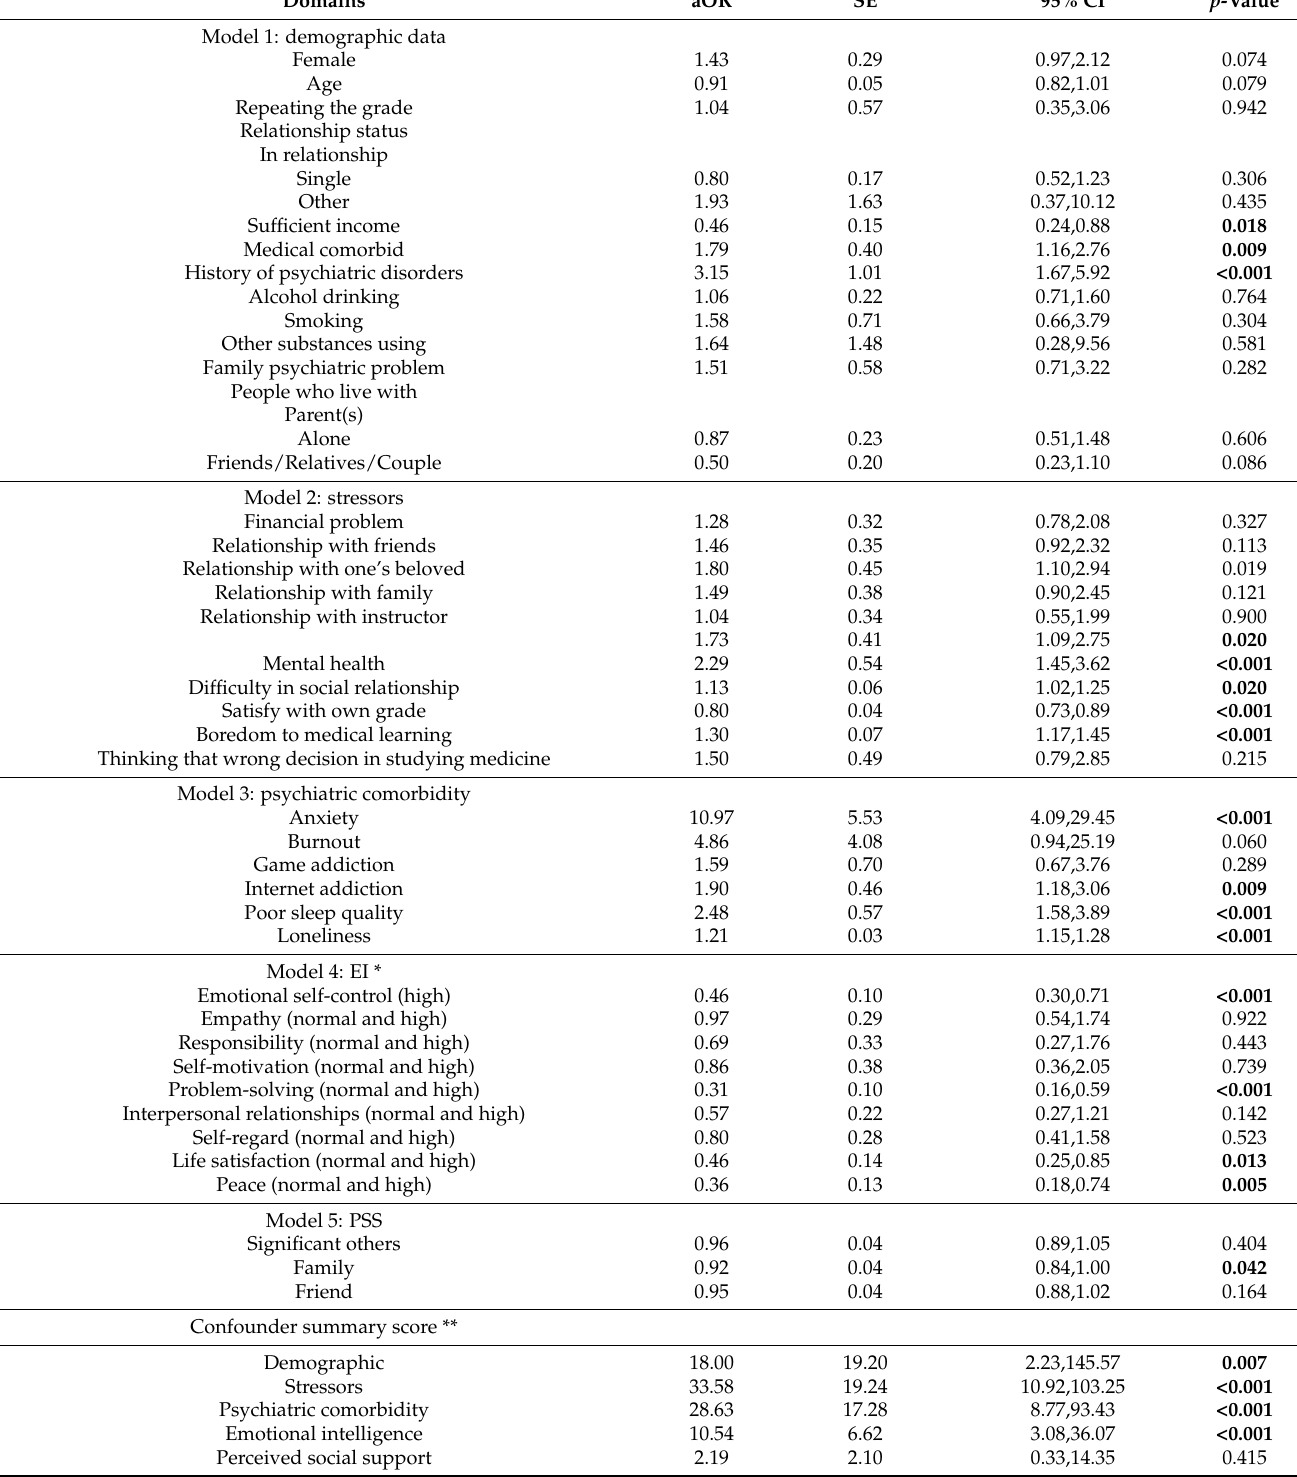
Table 4. Results of multivariable binary logistic